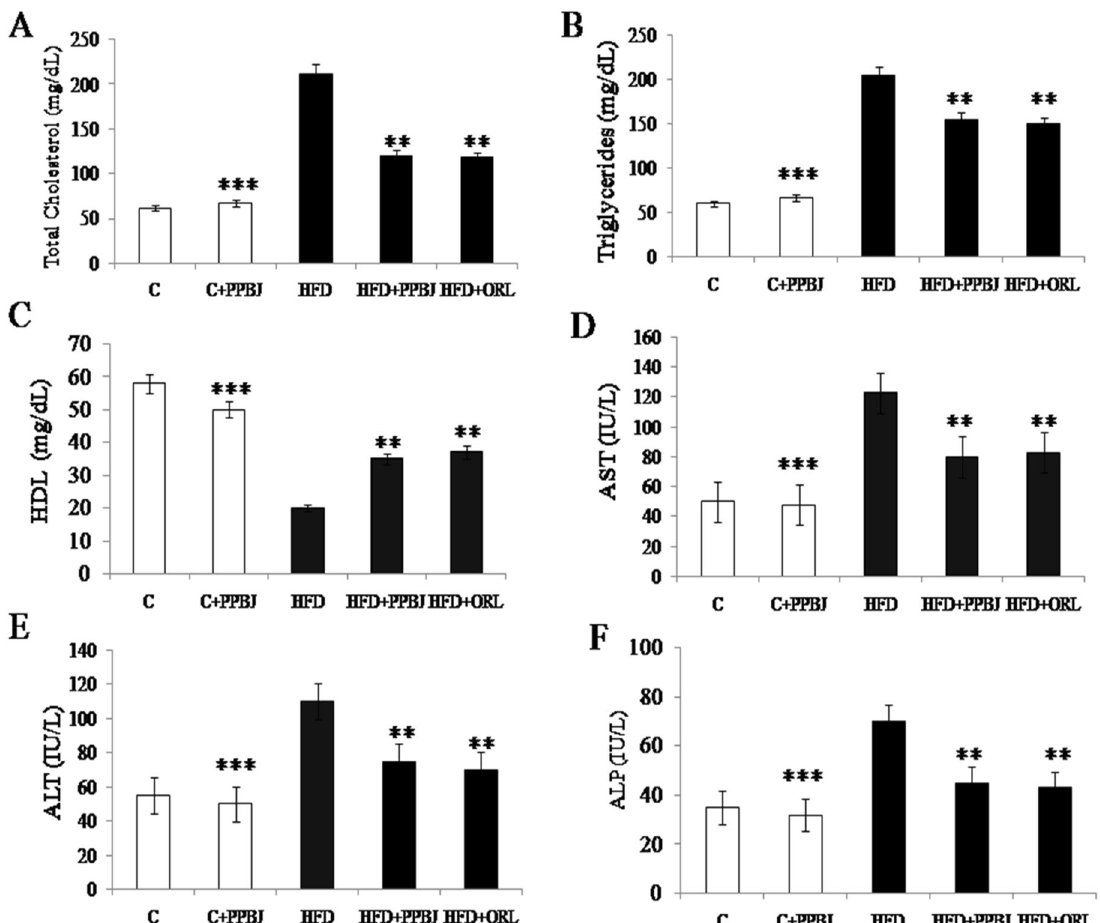
Figure 6. Effect of PPBJ on lipid metabolism and liver functional markers. ( A ) Total cholesterol. ( B ) Triglycerides. ( C ) HDL. ( D ) AST. ( E ) ALT and ( F ) ALP. HDL high density lipoproteins; AST aspartate transaminase; ALT alanine transaminase, and ALP alkaline phosphatase. Data was presented as mean ± SEM (n = 6 each group). Statistically significance compared to their respective controls ***p < 0.001; **p < 0.01; *p < 0.05 . Groups compared using one way ANOVA.